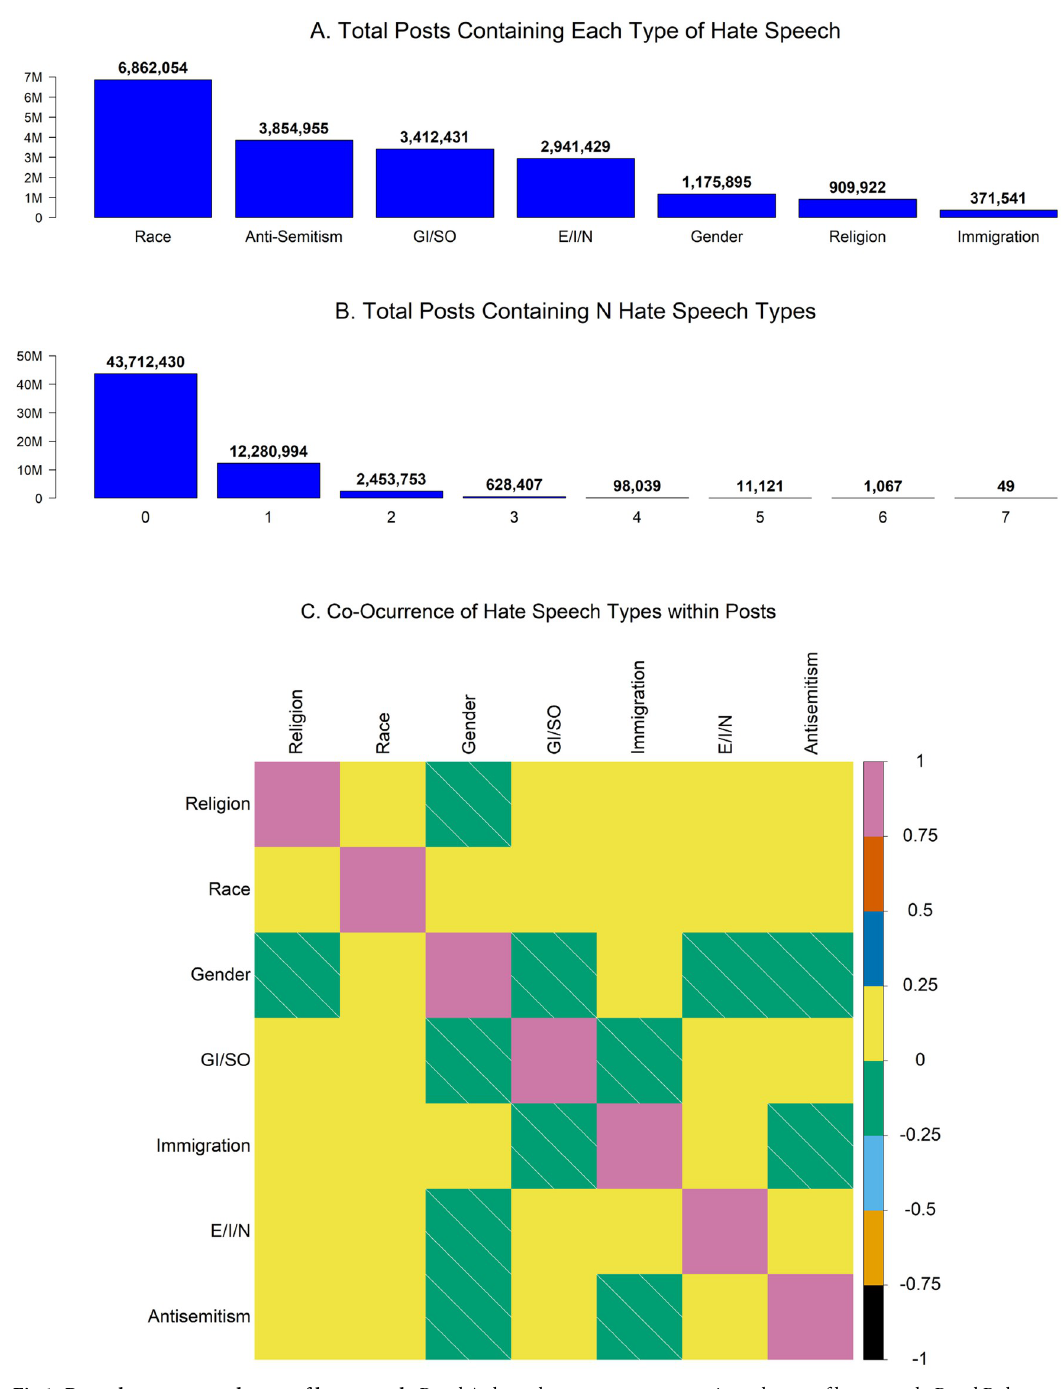
Fig 1. Posts, hate posts, and types of hate speech. Panel A shows how many posts contain each type of hate speech. Panel B shows how many posts contain different quantities of hate speech types. Panel C shows the pairwise correlations between hate speech types within posts. Diagonal lines indicate negative